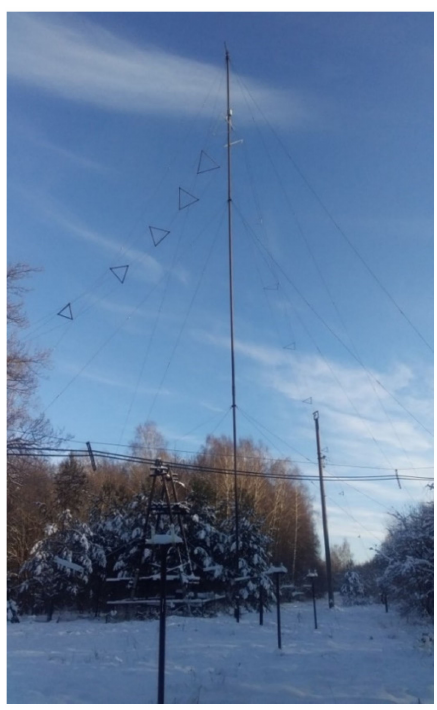
Figure 3. Antenna in village Vasilsursk: vertical Delta located on the 40-m